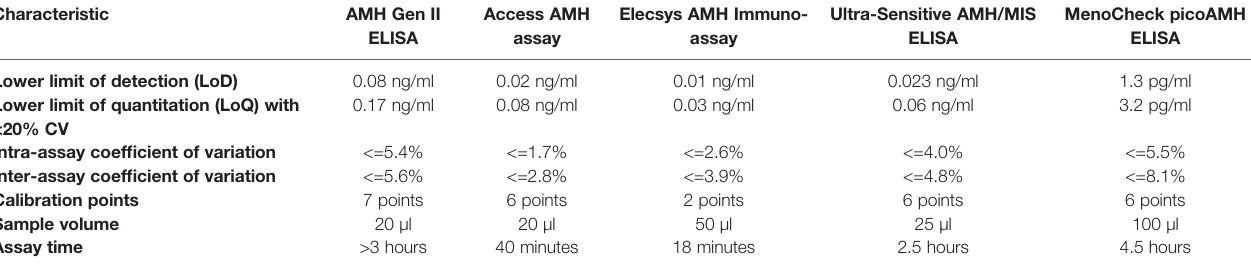
TABLE 1 | Analytical characteristics of the common commercial AMH assay methods according to information from the manufacturers.